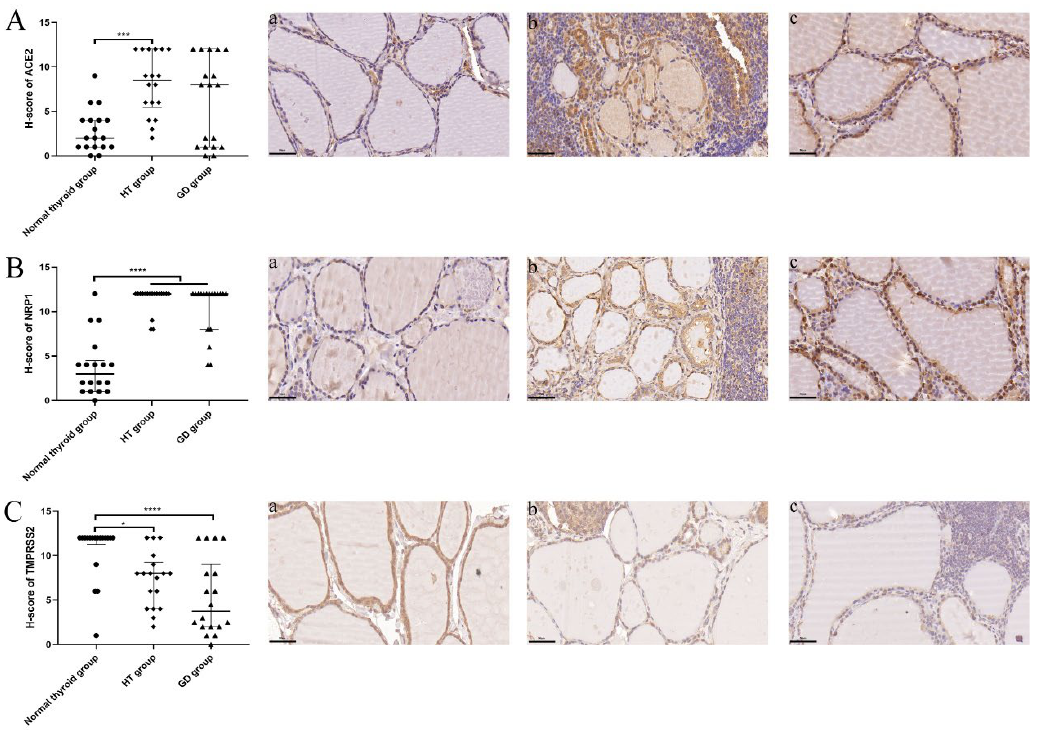
Figure 2. Comparison of the immunostaining scores for ACE2, NRP1, and TMPRSS2 in human thy- roid tissues from the normal thyroid, HT, and GD groups. ( A ) ACE2 immunostaining scores in hu- man thyroid tissues from the normal thyroid (a, n = 18), HT (b, n = 18), and GD (c, n = 18) groups were determined by IHC (magnification, ×400). ACE2 expression was significantly higher in the thyroid tissues of the HT group than in those of the normal thyroid group. ( B ) NRP1 immunostain- ing scores in human thyroid tissues from the normal thyroid (a, n = 18), HT (b, n = 18), and GD (c, n = 18) groups were determined by IHC (magnification, ×400). NRP1 expression was significantly higher in the thyroid tissues of the HT and GD groups than in those of the normal thyroid group. ( C ) TMPRSS2 immunostaining scores in human thyroid tissues from the normal thyroid (a, n = 18), HT (b, n = 18), and GD (c, n = 18) groups were examined by IHC (magnification, × 400). TMPRSS2 expression was significantly lower in the thyroid tissues of the HT and GD groups than in those of the normal thyroid group. * p < 0.05, *** p < 0.001, **** p < 0.0001. ACE2: angiotensin-converting enzyme 2; NRP1: neuropilin 1; TMPRSS2: transmembrane serine protease 2; H-score: histological score. The data are expressed as the median and interquartile range. Medians were compared by the Kruskal–Wallis test among the three